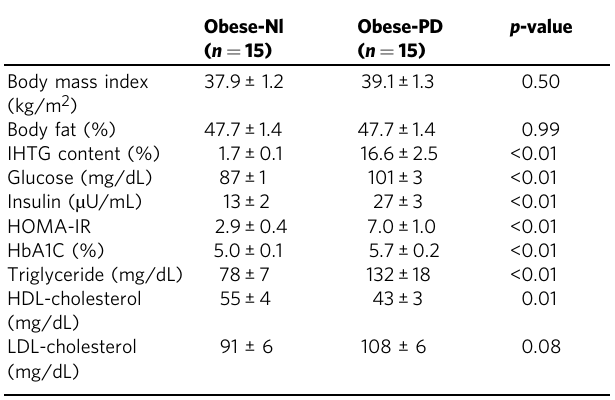
Table 1 Body composition and metabolic characteristics of study